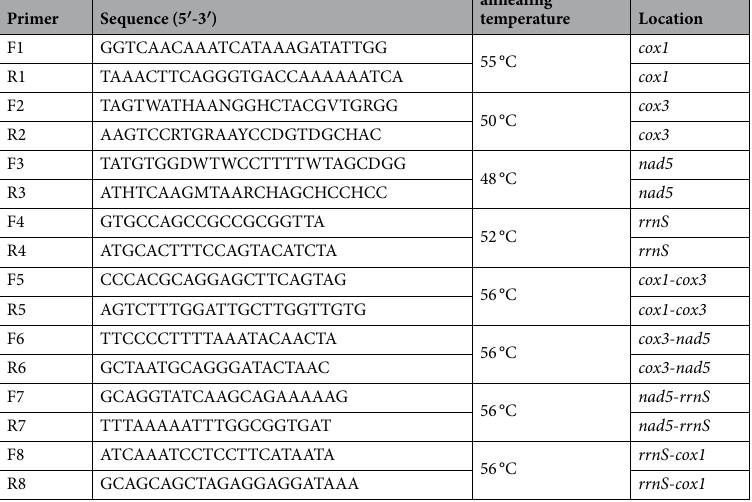
Species Family Size (bp) Accession No.